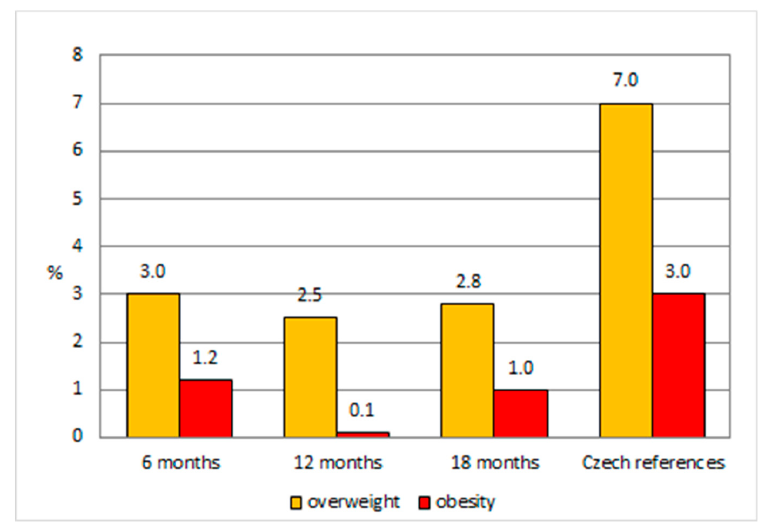
Figure 4. Prevalence of overweight and obesity in children breastfed for 6 months at 6, 12, and 18 months compared to the Czech references.